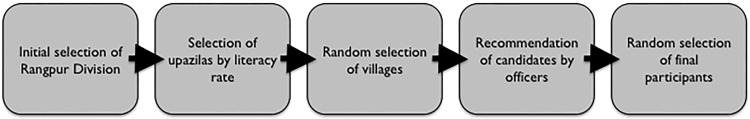
Sample selection pathway.